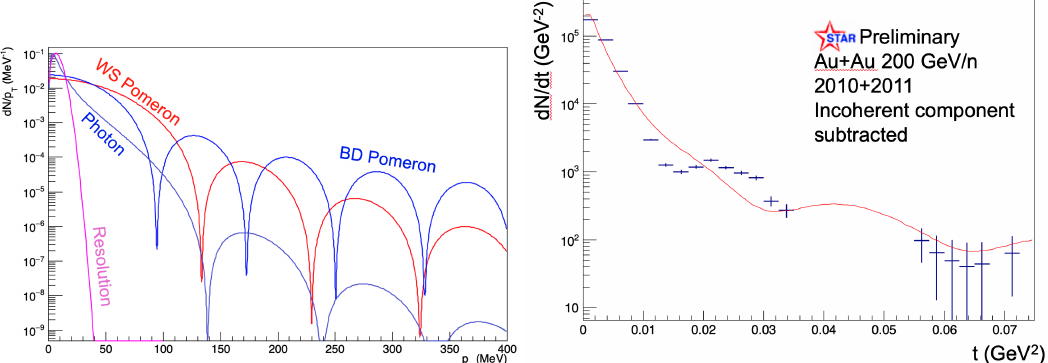
Figure 3: (left) The components of the fitting template, for the detector resolu- tion, photon p , and the Woods-Saxon and black-disk models. (right) The measured T / dt , with the fit d σ coherent